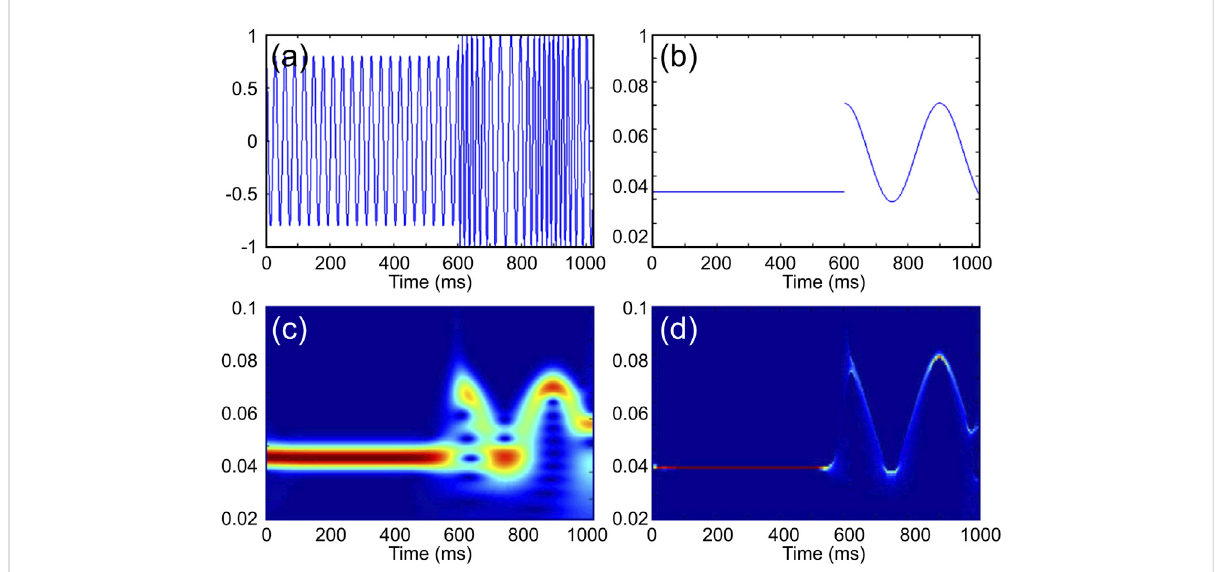
FIGURE 1 Examplesoftime – frequencyrepresentationsofthecontinuouswavelettransform(CWT)andsynchrosqueezingtransform(SST). (A) Signal s (t) = (t) = 0.7cos( π t /15) for 0 ≤ t ≤ 600 ms and by s (t) = cos( π t /10+2 π sin( π t/150)) for 601 ≤ t ≤ 1,024 ms; (B) instantaneous s 1 (t) +s 2 (t) is de fi ned by s 1 2 frequency for its two components (left), ω (t) = 1/30 for 0 ≤ t ≤ 600 ms and ω (t) = ( π /10+2 π cos( π t/150)*( π /150))/(2 π ); (C) example of a continuous wavelet transform of s (t), with a Morlet wavelet [this is plotted with MATLAB, with the “ jet ” colormap; red indicates higher amplitude]; and (D) example of the synchrosqueezing transform(SST) (this is plotted with MATLAB, with the “ jet ” colormap; red indicates higher